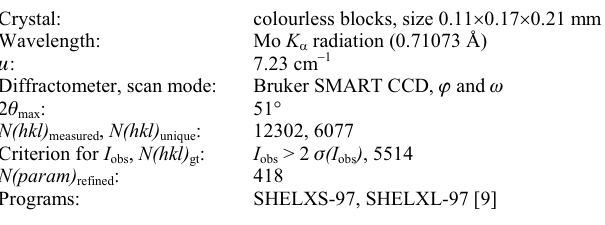
Table 1. Data collection and